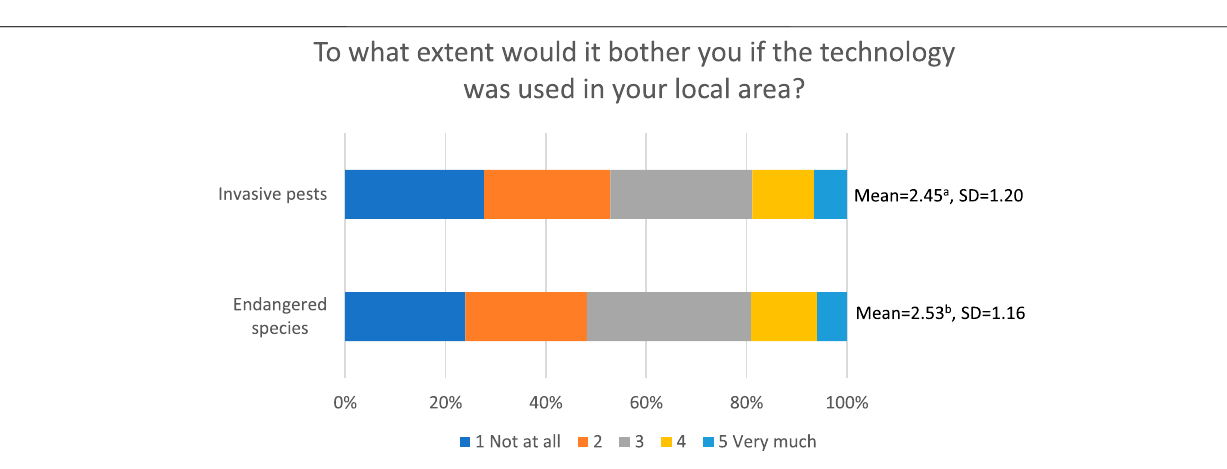
Frontiers in Environmental Science |